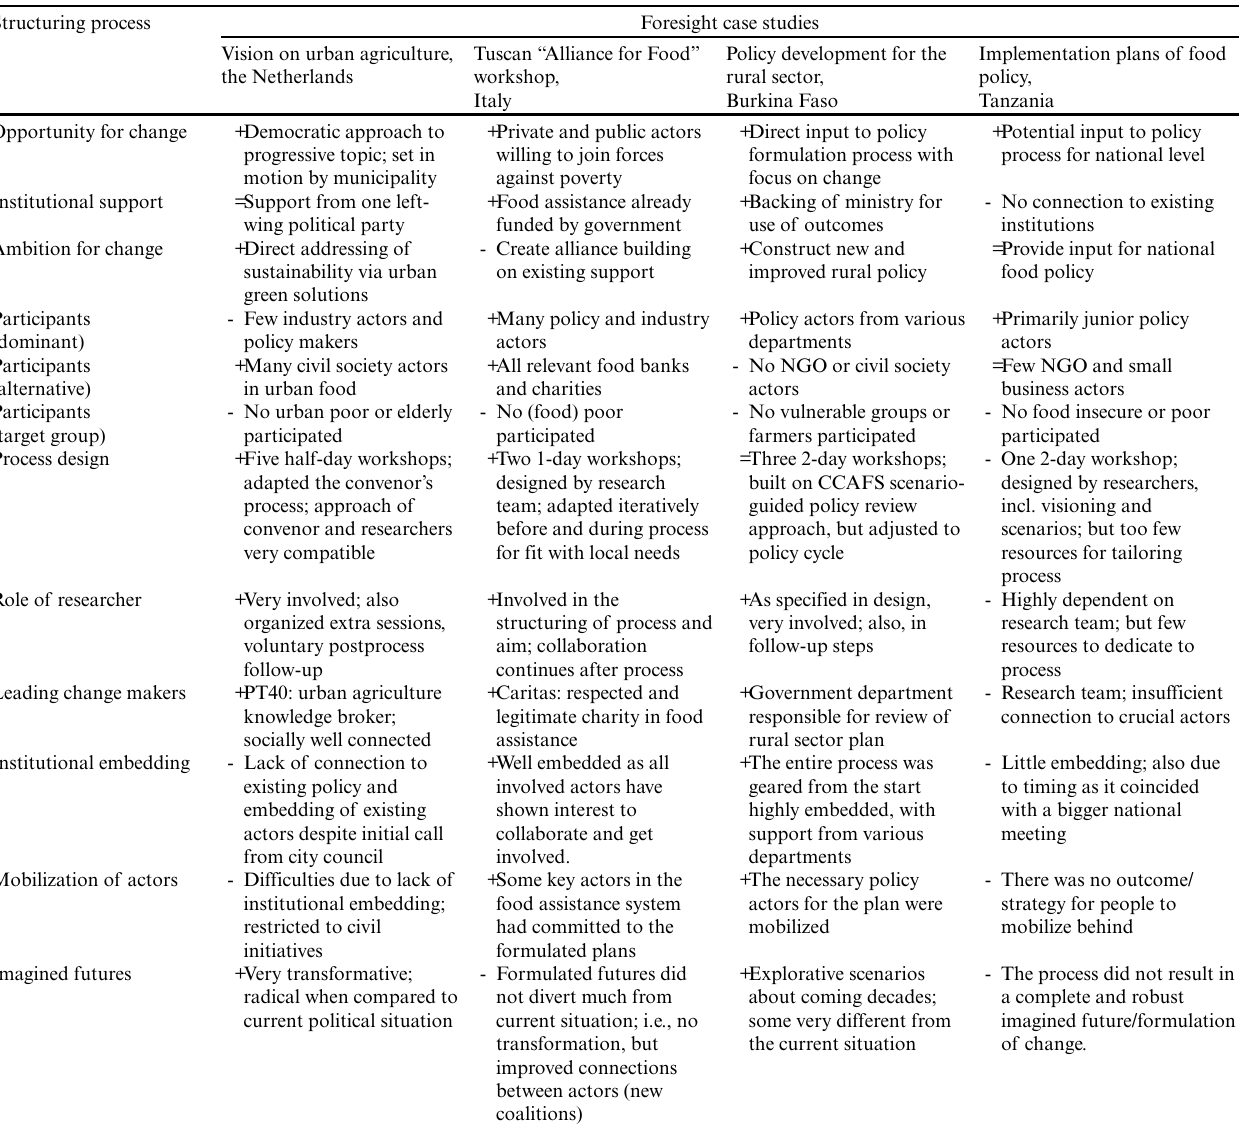
Table 3 . Scoring † and description of status of the processes that influence foresight impact in the four cases studies. Structuring